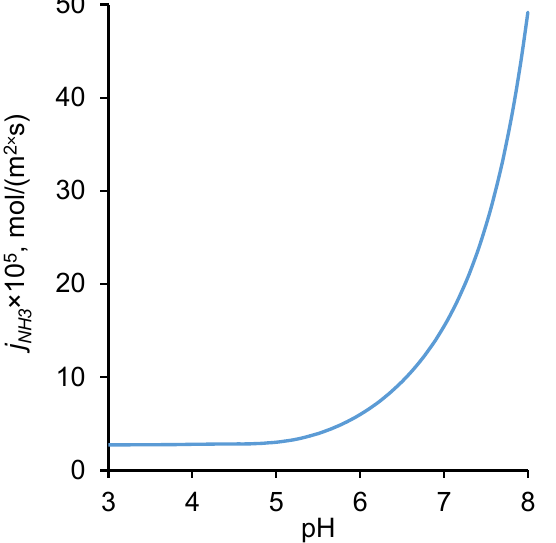
Figure 11. Dependence of the theoretical NH 4 Cl flux through an AMX membrane on the pH of the feed electrolyte solution. The input parameters are presented in Table 1.